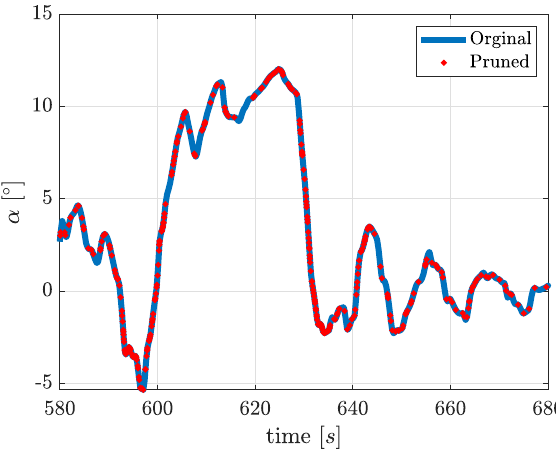
Figure 11. Example of original data and pruned